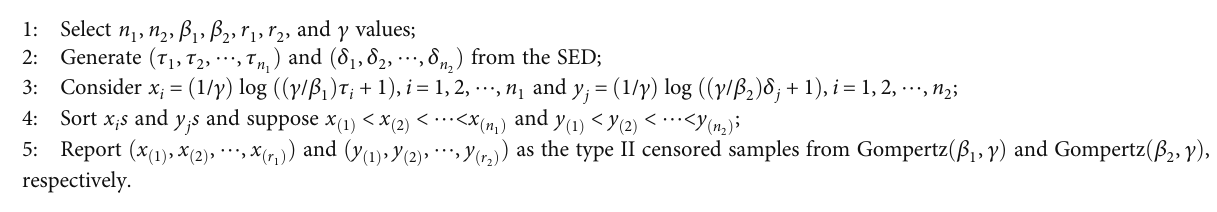
Algorithm 2: The type II censored sample generation algorithm.